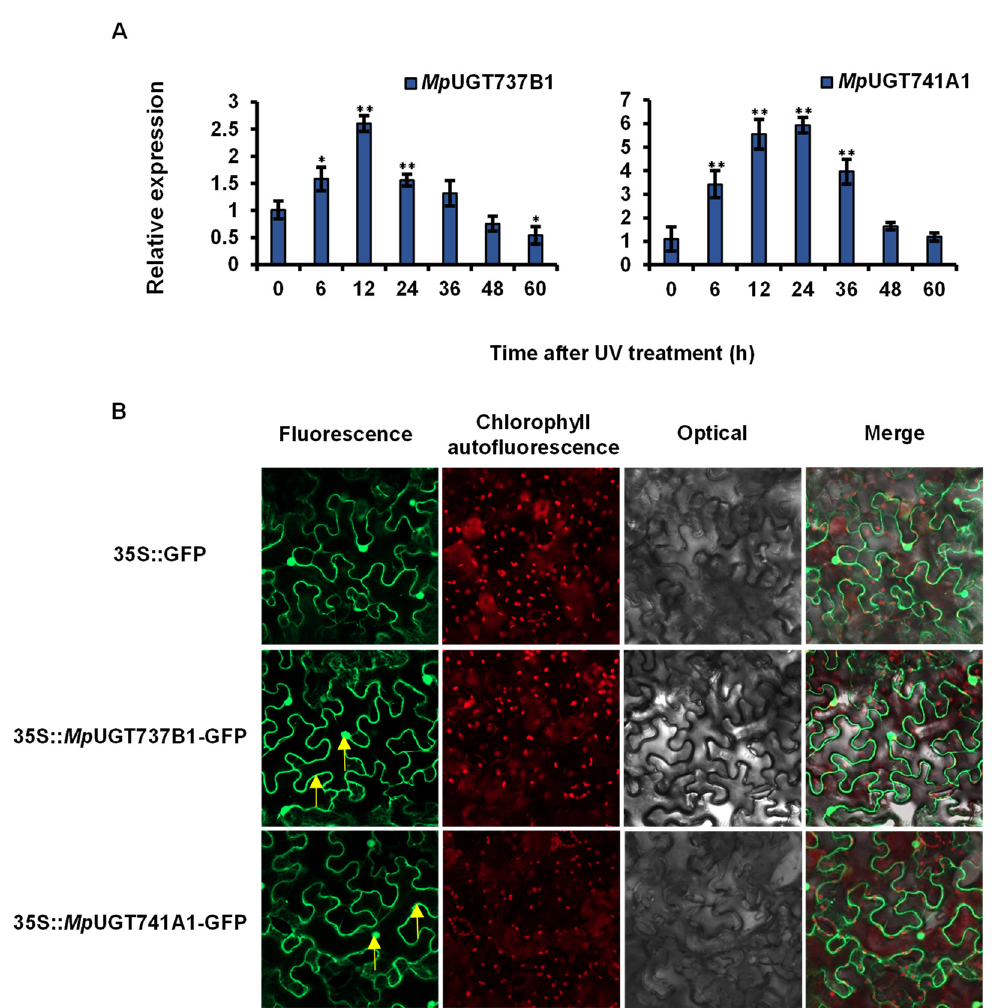
Figure 4. Expression patterns of Mp UGTs in response to ultraviolet (UV) light stress ( A ) and sub- cellular localization of Mp UGTs ( B ). ( A ) Data are shown in the form mean ± SD ( n = 3). *, ** Means differ significantly from the level of sample t = 0 h at p < 0.05 and p < 0.01, respectively. ( B ) The GFP signal appears green and the chlorophyll signal appears red. Yellow arrows show the luminous form of gene localization.